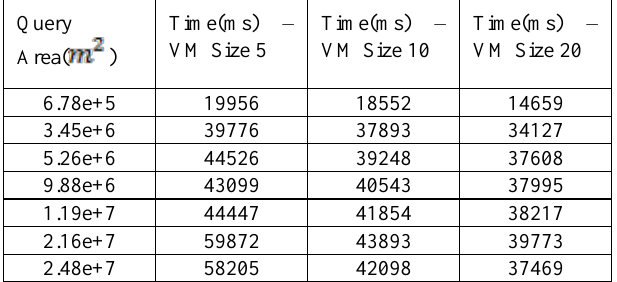
Table 2. The query time under different query area and cluster